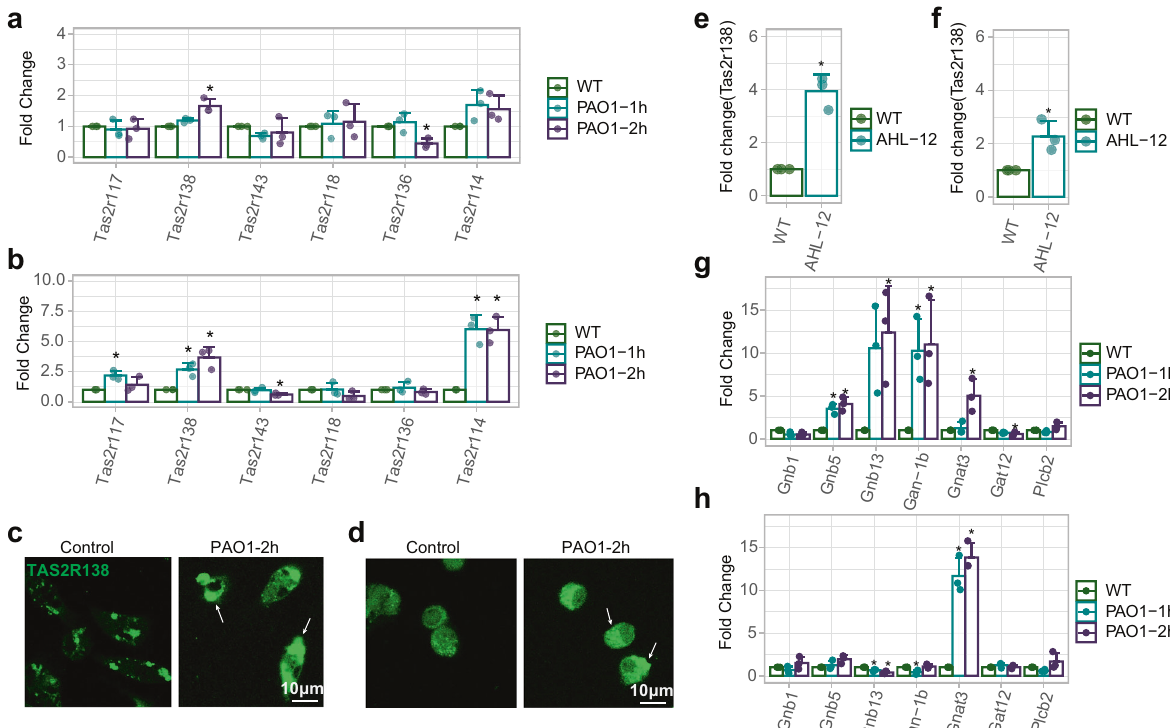
Fig. 1 Tas2r138 increased after P. aeruginosa infection. AMs and neutrophils were isolated from C57BL/6N mice and infected with PAO1 (MOI: 5:1) for 1 or 2 h. Total RNA was extracted for reverse transcription and qPCR. a – d The Tas2r family mRNAs were expressed as the fold difference to GAPDH in neutrophils ( a ) and AMs ( b ), and the protein expressions in neutrophils and AMs were exhibited by confocal microscopy imaging ( c , d ) (arrows showing the increased TAS2R138). e , f AMs and neutrophils were infected with AHL-12 (50 µM) for 2 h. The Tas2r138 mRNAs were expressed as the fold difference to GAPDH in neutrophils and AMs. g , h The G-protein family mRNAs were expressed as the fold difference to GAPDH in neutrophils and AMs. The results were expressed as the mean ± SD and the signi fi cant difference level between two groups was de fi ned by one-way ANOVA with Tukey post hoc tests, * p < 0.05 (control short as CT in all fi homeostasis. Perilipin-2 (PLIN2) is the well-characterized protein that localizes in the LDs and helps LDs enter into lysosomes through chaperone-mediated autophagy (CMA), dependent on PLIN2 – heat shock cognate 71 kDa protein (HSC70) – lysosome- associated membrane protein 2 (LAMP2). 23